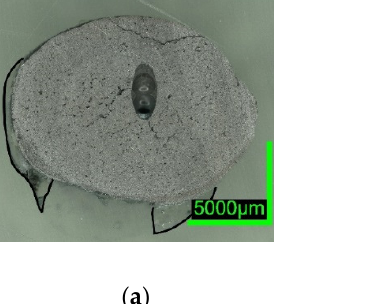
Figure 10. Digital microscope images of ( a ) C800-SAF-1; ( b ) C800-EAF-1, dipped into slag.